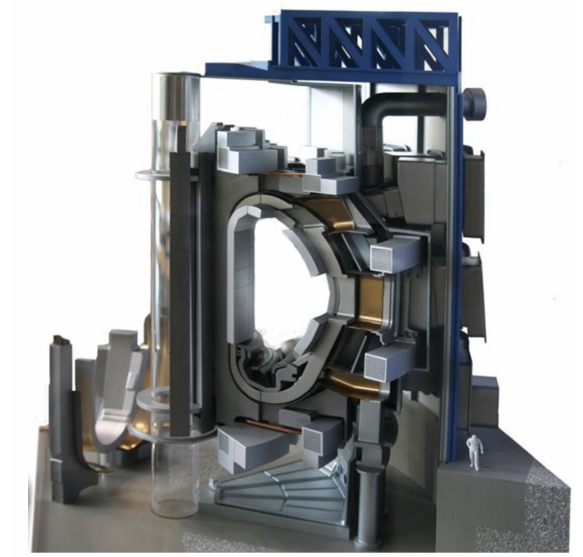
Figure 1. International Thermonuclear Experimental Reactor (ITER) reactor section